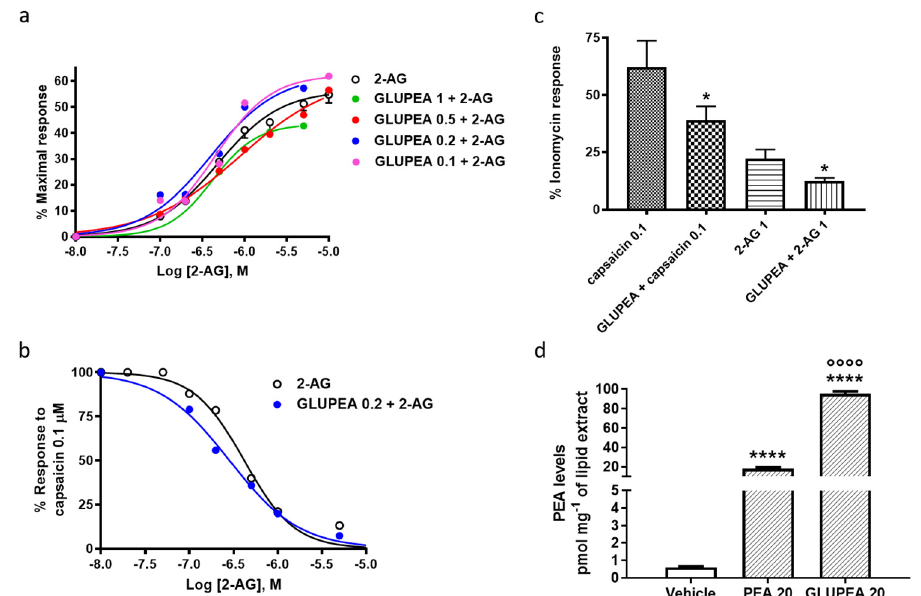
Figure 4. Effect of GLUPEA on 2-AG-induced TRPV1 channel activation and desensitization in human recombinant (HEK)-TRPV1 cells ( a ) Effect of GLUPEA (0.1, 0.2, 0.5, 1 µ M) on the intracellular Ca 2+ elevation by 2-AG in HEK-TRPV1 cells. GLUPEA was pre-incubated with cells 5 min prior to 2-AG. ( b ) Effect of GLUPEA (0.2 µ M) on 2-AG-induced TRPV1 channel desensitization of the effect of capsaicin (0.1 µ M) in HEK-TRPV1 cells. GLUPEA was pre-incubated with cells 5 min prior to 2-AG treatment. The effect on the intracellular Ca 2+ of capsaicin (0.1 µ M) alone was set as 100%. Data are representative of n = 4 separate determinations (means ± s.e.m.). ( c ) Effect of GLUPEA (20 µ M) on the intracellular Ca 2+ elevation by capsaicin (0.1 µ M) or 2-AG (1 µ M) in HEK-TRPV1 cells. HEK-TRPV1 cells were untreated or pre-treated for 6 h with GLUPEA (20 µ M). Data are representative of n = 4 separate determinations (means ± s.e.m.). Statistical analyses were carried out using the Student’s t test. (* p < 0.05, versus capsaicin 0.1 or versus 2-AG 1 µ M). ( d ) PEA levels were measured in HEK-TRPV1 cells treated for 6 h with GLUPEA (20 µ M) or PEA (20 µ M). Data are representative of n = 8 separate determinations (means + s.e.m.). Statistical analyses were carried out using one-way ANOVA followed by the Newman–Keuls multiple comparison test (**** p < 0.001, versus vehicle; ◦◦◦◦ p < 0.001, versus PEA 20 µ